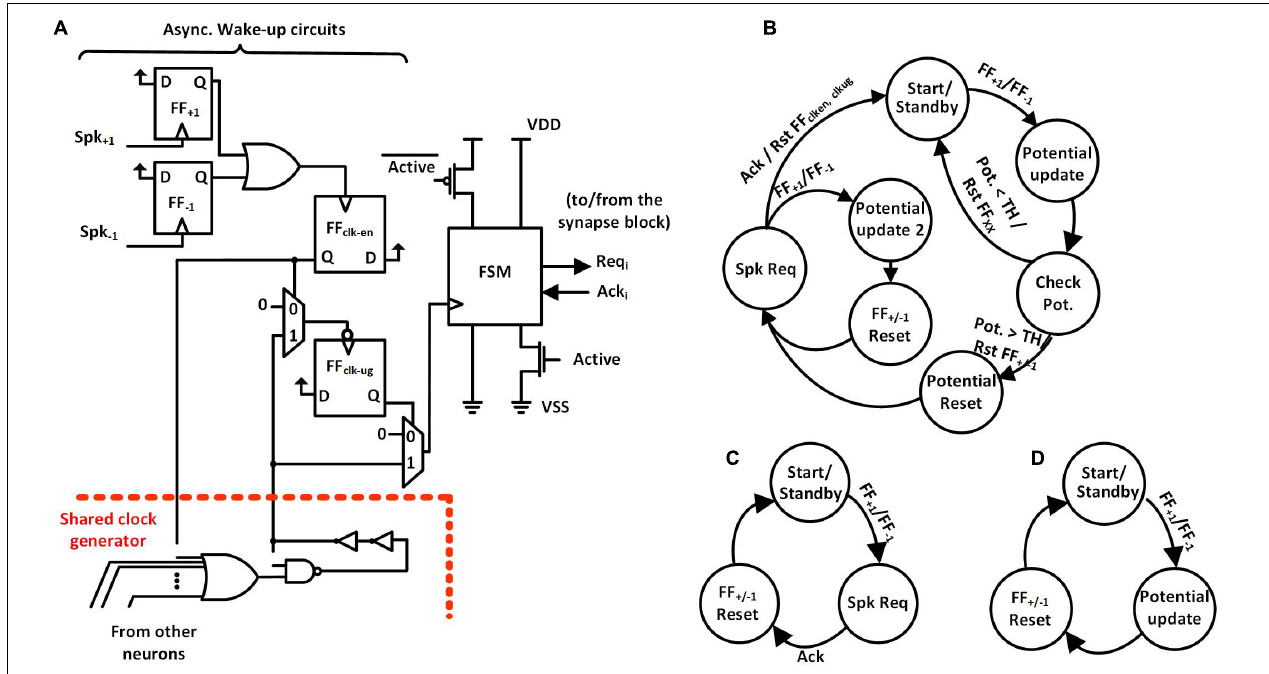
FIGURE 2 | (A) Neuron Block Architecture with wake-up circuits on the left, FSM with zigzag power gating on the right and Shared Clock generator on the bottom. (B) Hidden Neuron FSM. (C) Input Neuron FSM. (D) Output Neuron FSM.